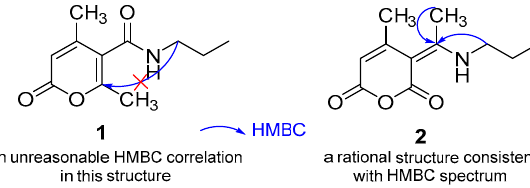
Figure 2. The observed HMBC correlations in compound 2 compared to compound 1 .